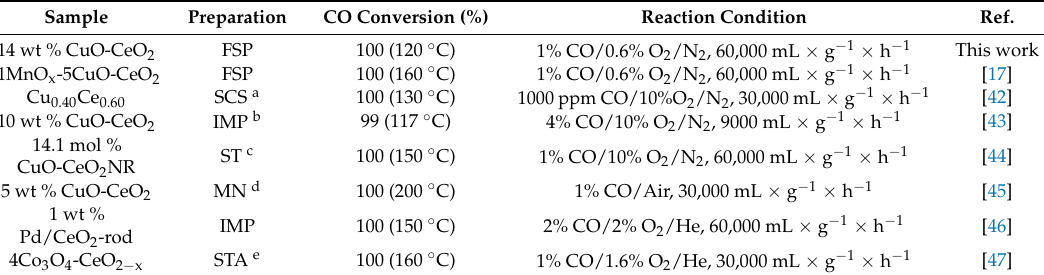
Figure 6. ( a ) the curve of CO conversion; ( b ) the reaction rate of all catalysts at 80 ◦ C; ( c ) Arrhenius plots of catalytic CO oxidation over all samples; ( d ) the effect of water vapor on the activities of the 14% CuCe sample at 120 ◦ C. (weight hourly space velocity (WHSV): 60,000 mL × g − 1 × h − 1 ; 1 vol % CO, 0.6 vol % O 2 ) . Table 3. Comparison on CO oxidation activity over CeO 2 based catalysts via different methods. Sample